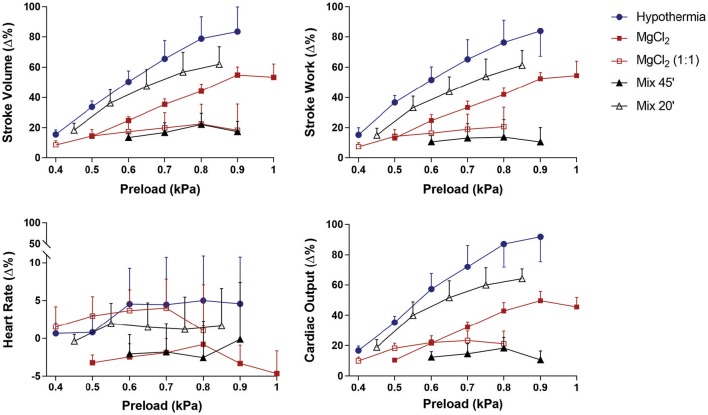
Effect of preload increase on stroke volume (SV), stroke work (SW), heart rate (HR), and cardiac output (Q) in the isolated Octopus vulgaris systemic heart (n = 5, 6 each treatment) following removal under hypothermia (4°C), MgCl2, MgCl2 (1:1), and MgCl2+EtOH mixture following 20 (Mix 20′) and 45 (Mix 45′) minutes of exposure. Results are expressed as mean ± SEM of the percentage (%) change from baseline (see Table 2). Repeated-measures ANOVA revealed no significant differences among treatments, but treatments × preload effects were significant with the exception of HR (SV: F(4, 16) = 2.16, p = 0.121; treatments × preload F(24, 96) = 3.29, p < 0.001; SW: F(4, 16) = 2.62, p = 0.074; treatments × preload F(24, 96) = 4.42, p < 0.001; HR: F(4, 16) = 0.84, p = 0.518; treatments × preload F(24, 96) = 0.31, p = 1.000; Q: F(4, 16) = 0.36, p = 0.831; treatments × preload F(24, 96) = 6.14, p < 0.001. MANOVA was utilized to evaluate pairwise differences in preload values between MgCl2 (1:1) and (Mix 45′) and the other curves (see text for details). The largest response in terms of Q, SV, and SW was obtained with hypothermia followed by treatment with Mix 20′ and MgCl2. Hypothermia, Q = 91.8 ± 17.2%; SV = 83.4 ± 14.9%; SW = 83.9 ± 15.9%; MgCl2, Q = 49.6 ± 4.3%; SV, 54.9 ± 3.7%; SW = 52.5 ±2.9%; Mix 20′, Q = 64.1 ± 7.4%; SV = 61.9 ± 11.5%; SW = 56.5 ± 10.5%. MgCl2 (1:1) and Mix 45′ showed the worst response revealed by an impaired ability to respond to preload increases [MgCl2 (1:1): Q = 23.3 ± 6.4%; SV = 22.5 ± 11.5%; SW = 20.8 ± 11.4%; Mix 45′, Q = 22.9 ± 4.0%; SV = 22.2 ± 7.4%; SW = 13.9 ± 11.5%].